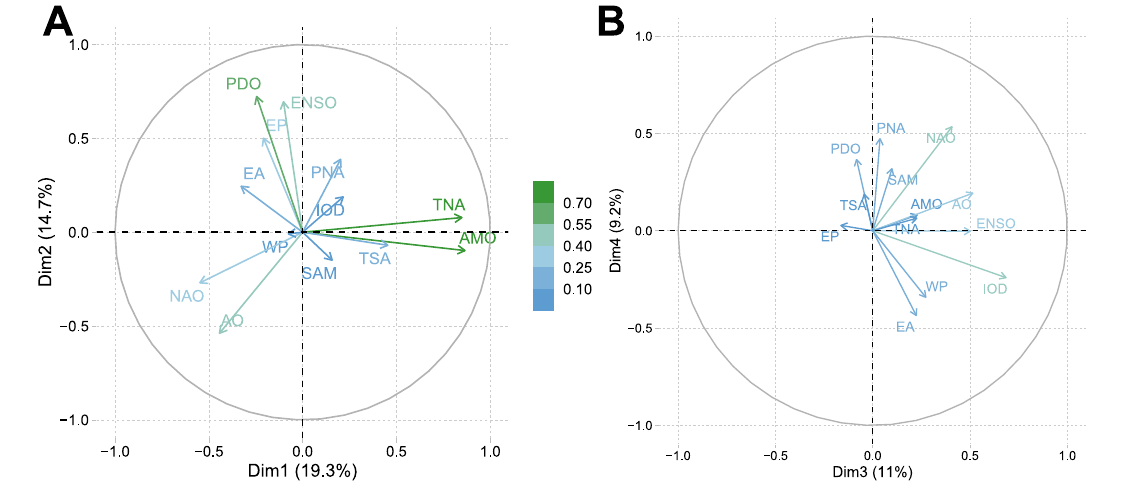
Fig. 4 | Relationships among climate teleconnections (CT) from 1982 to 2018 using Principal Component Analysis (PCA). A First versus second PCA compo- nent (34.0% of variance); ( B ) third versus fourth PCA component (20.2% of